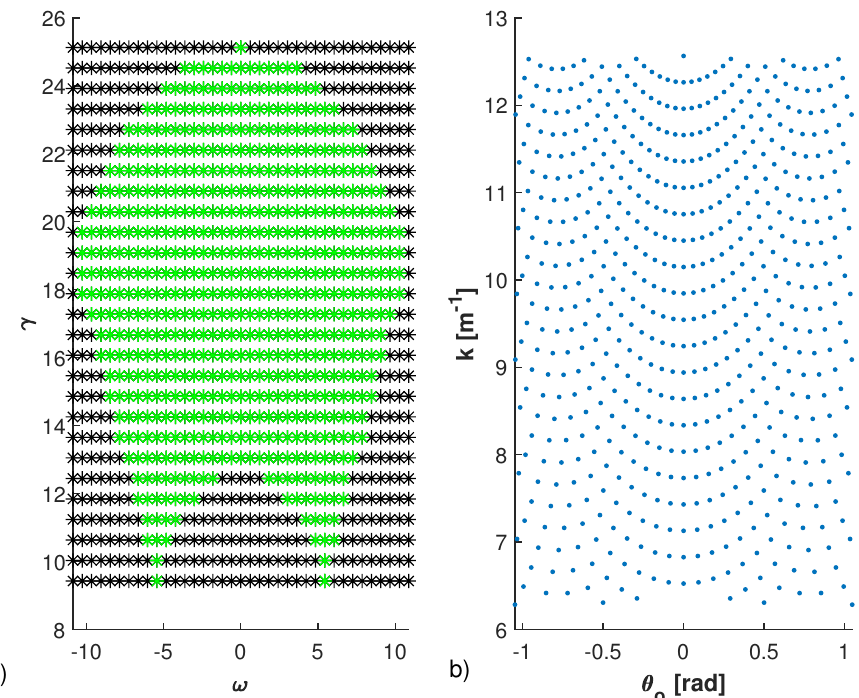
Figure 3. Sampling points obtained by collecting the field with uniform step equal to π ν = 1.05 in the variables ω ( k , θ o ) and γ ( k , θ o ) . In panel ( a ), the points are shown in ω − γ domain, while in panel ( b ) in k − θ o domain. In particular, in panel ( a ) the black points are supported on a rectangular domain, while the ones that belong to Ω are shown in green color. In panel ( b ) only the N = 619 points in k − θ o domain that correspond to the green ones are shown. The parameters are ID = [ − 5 λ max ,5 λ max ] × [ − 5 λ max ,5 λ max ] , Ω o = [ − π λ max = 1 m the wavelength at minimum